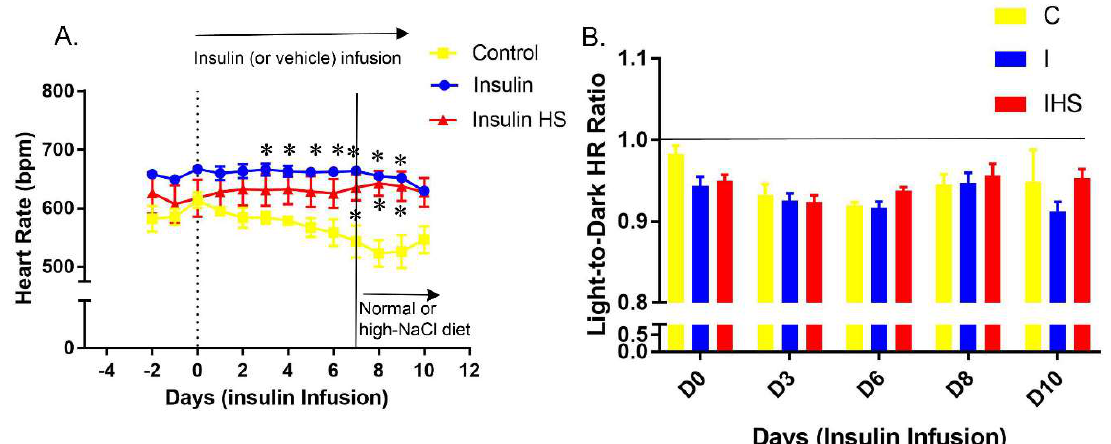
Figure 2. Heart rate—( A ) Daily average heart rate (HR) in control (vehicle infused, 1% NaCl diet), insulin infused (fed 1% NaCl all study) and insulin infused plus high-NaCl diet (4%, HS) treated mice; in various periods ( B ) light-to-dark period HR ratio on various days (mean ± sem, n = 4–7/group); * indicates a significant difference from control, by multiple comparisons testing following a significant one-way ANOVA ( p < 0.05).